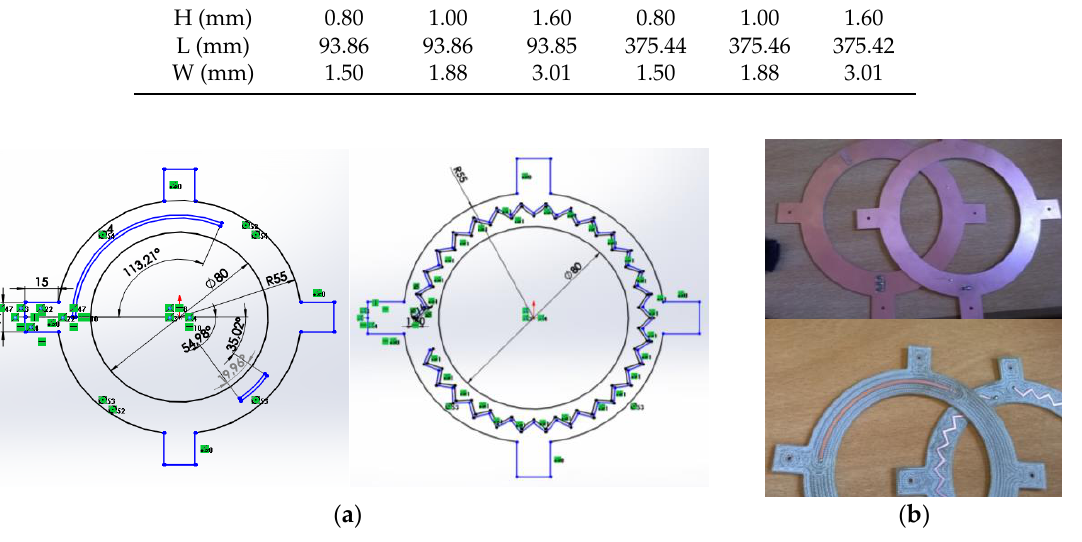
Figure 3. ( a ) Diagrams of rotor coupler line (longer line) and stator zigzag-shaped coupler line; ( b ) fabricated couplers.